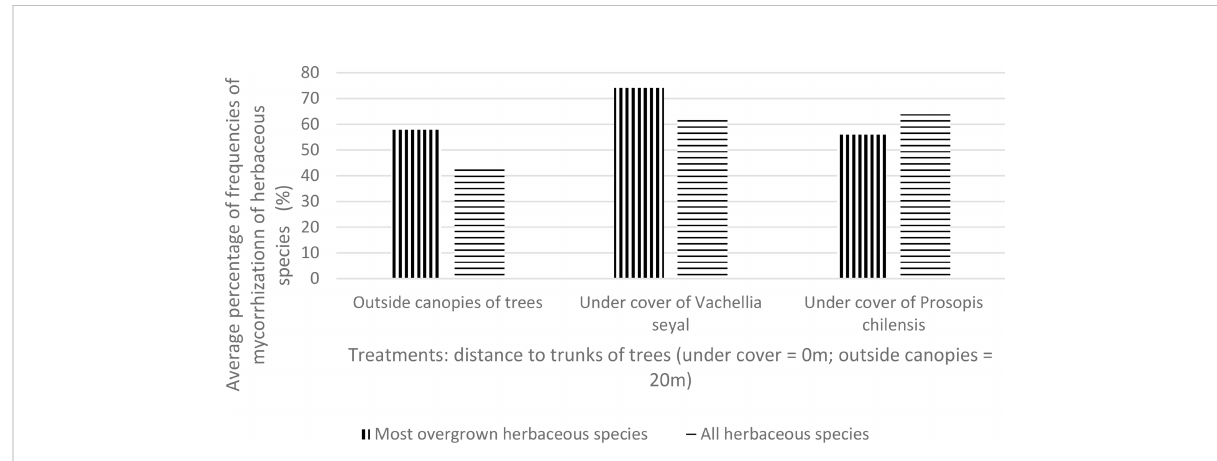
FIGURE 7 Average mycorrhization rate of natural living roots of herbaceous species with the highest cover indexes beneath the trees and outside the canopies of trees.